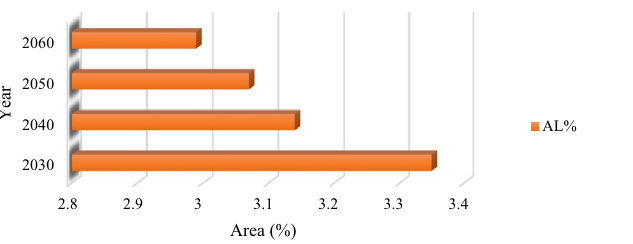
Figure 7. Agricultural lands variation within the LUB form 2002 to 2021, generated in Microsoft Excel 2022 software (www. micro soft.